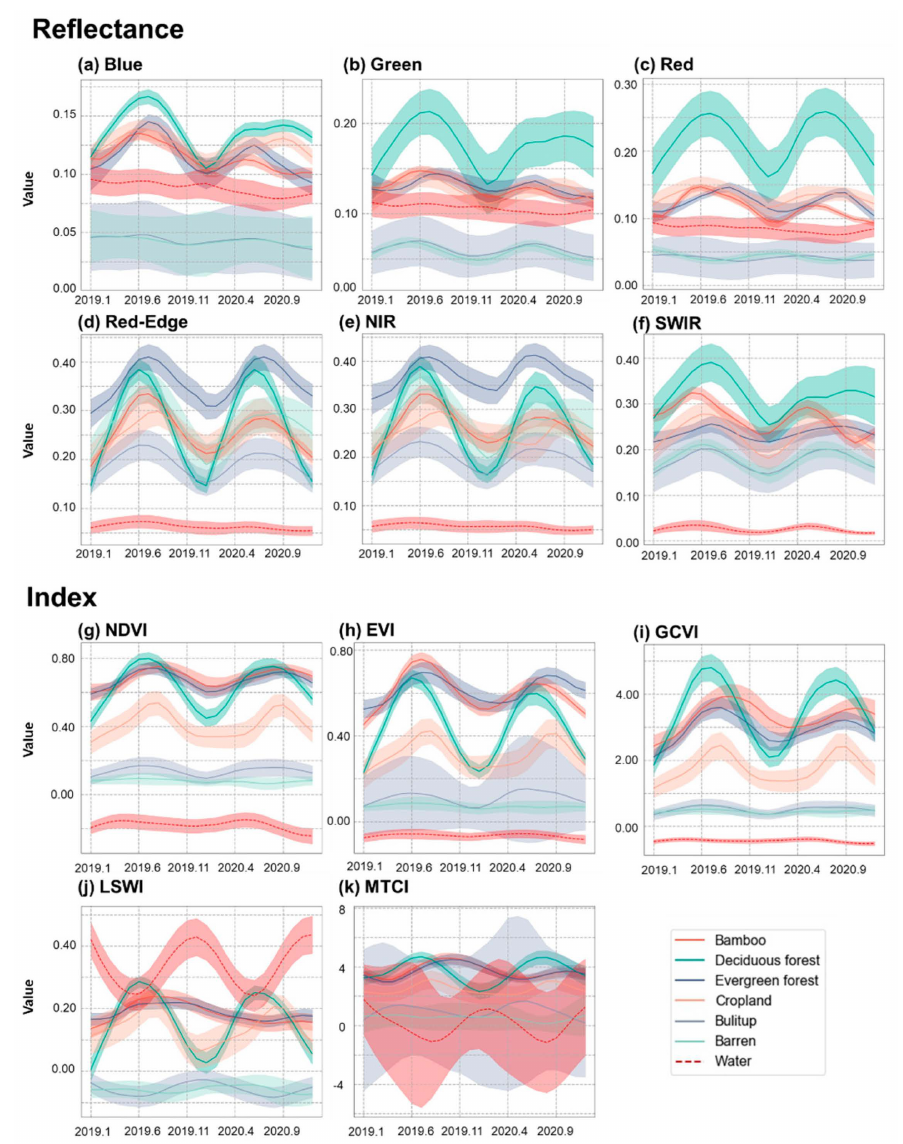
Figure 4. Temporal patterns for different categories. ( a – f ) display the temporal patterns for the reflectance of six bands. ( g – k ) display the temporal patterns for five vegetation indices. The shade of each line represents the standard error calculated from all field